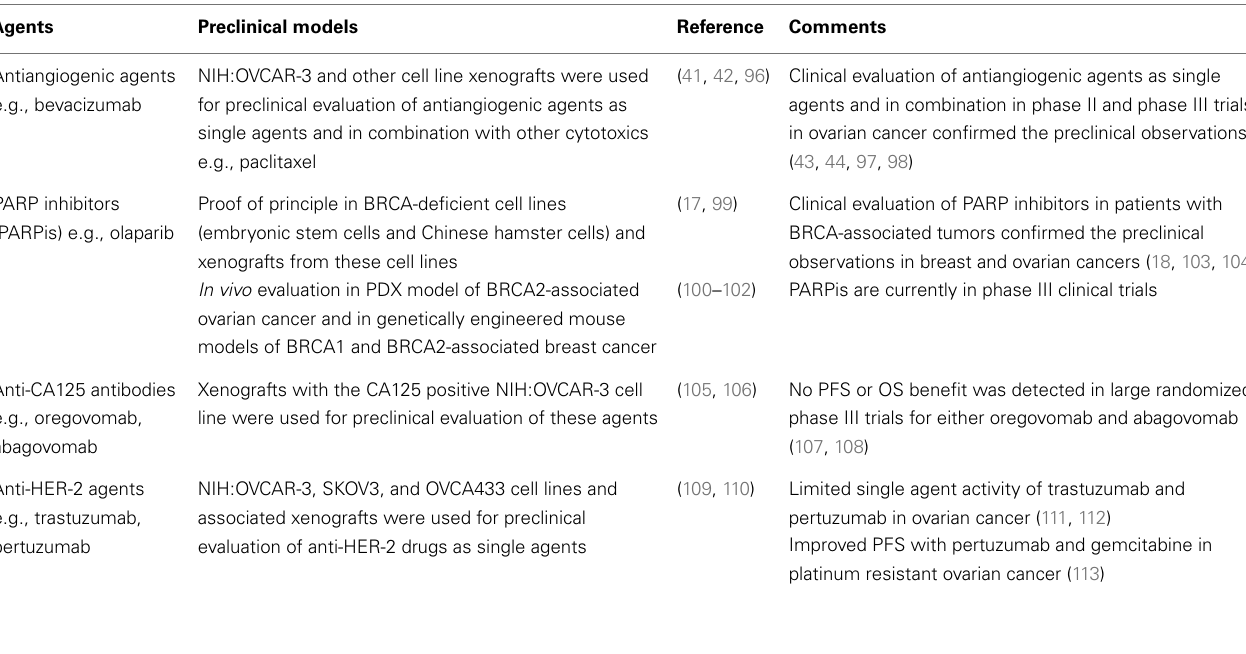
Table 3 | Preclinical evaluation of selected experimental agents used against EOC.